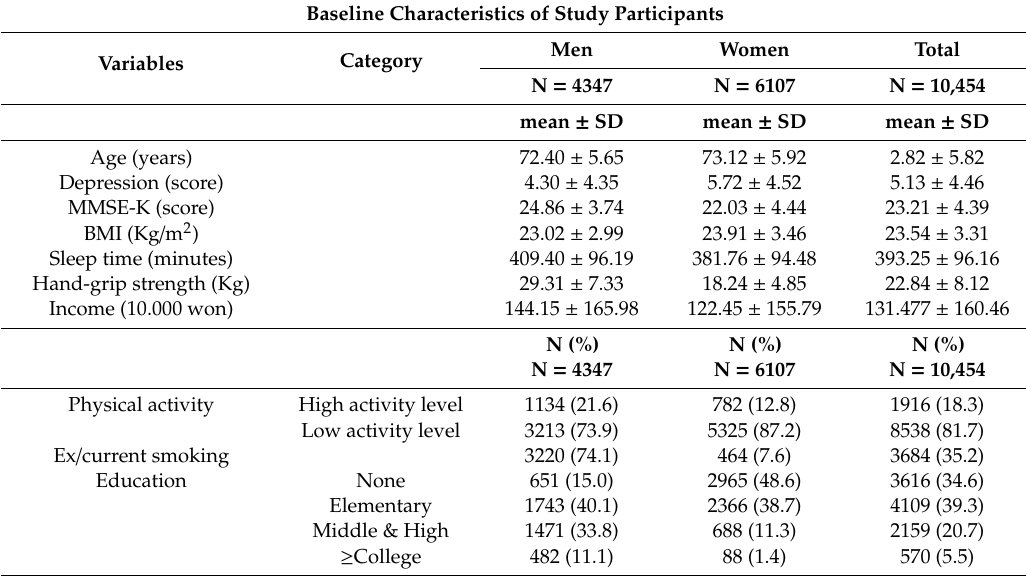
Table 1. Subject